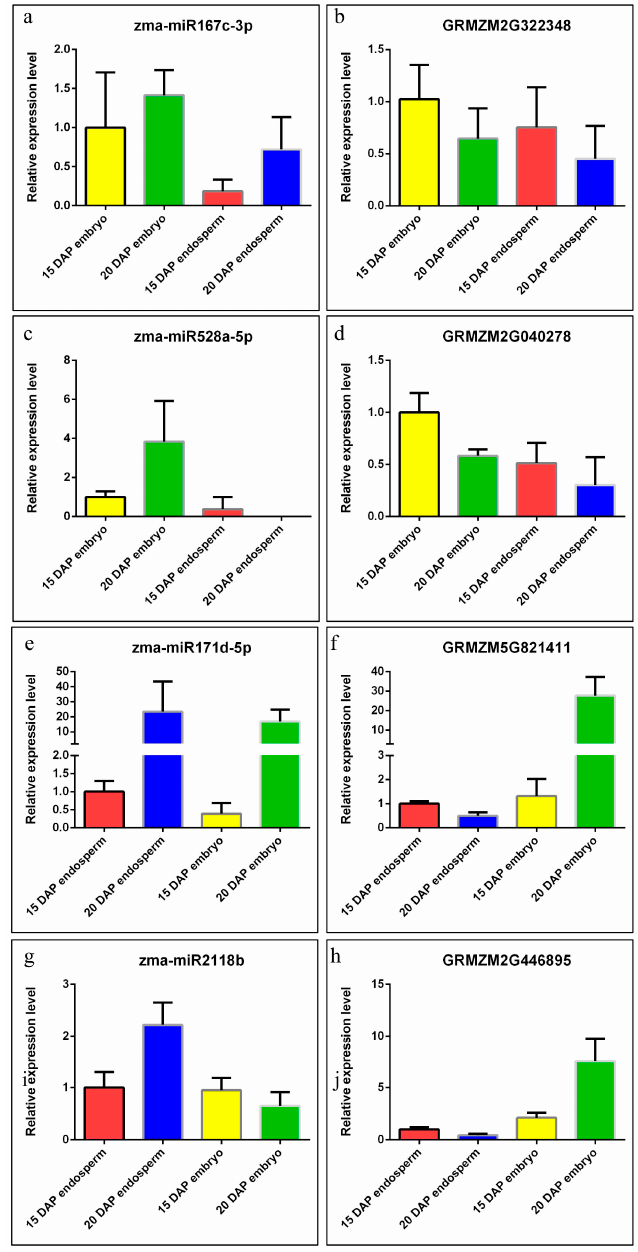
Figure 6. The expression patterns of the embryo-specific and endosperm-specific miRNAs and their target genes at 15 DAP and 20 DAP, respectively. The expression levels of zma-miR167c-3p ( a ), zma- miR528a-5p ( c ), zma-miR171d-5p ( e ), and zma-miR2118b ( g ) were detected by the